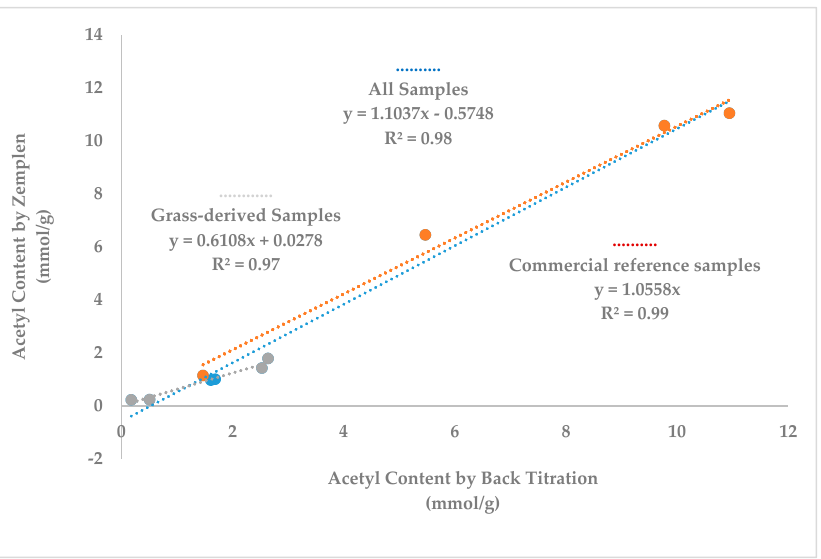
Figure 4. Corrrelations between acetyl contents measured by Zemplén and back titration methods validating the accuracy and sensitivity of the Zemplén method for acetate analysis in lignocellulosics.